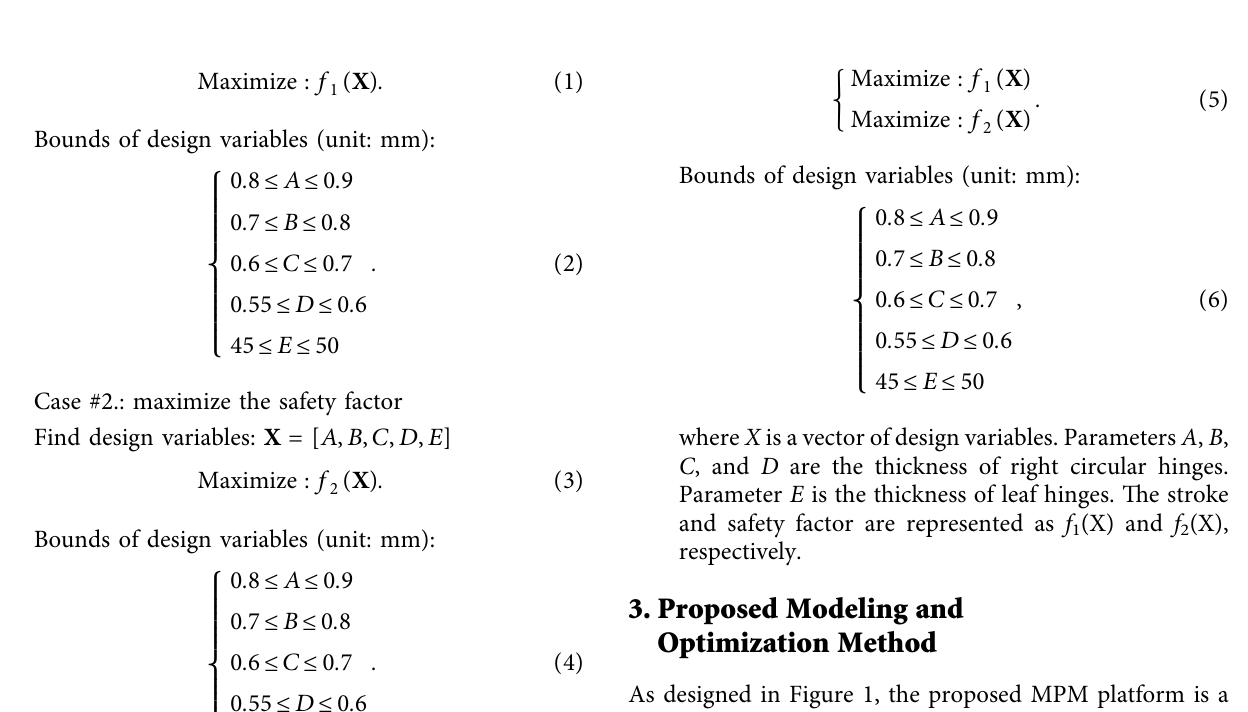
Figure 3: Application of microrobotic platform for